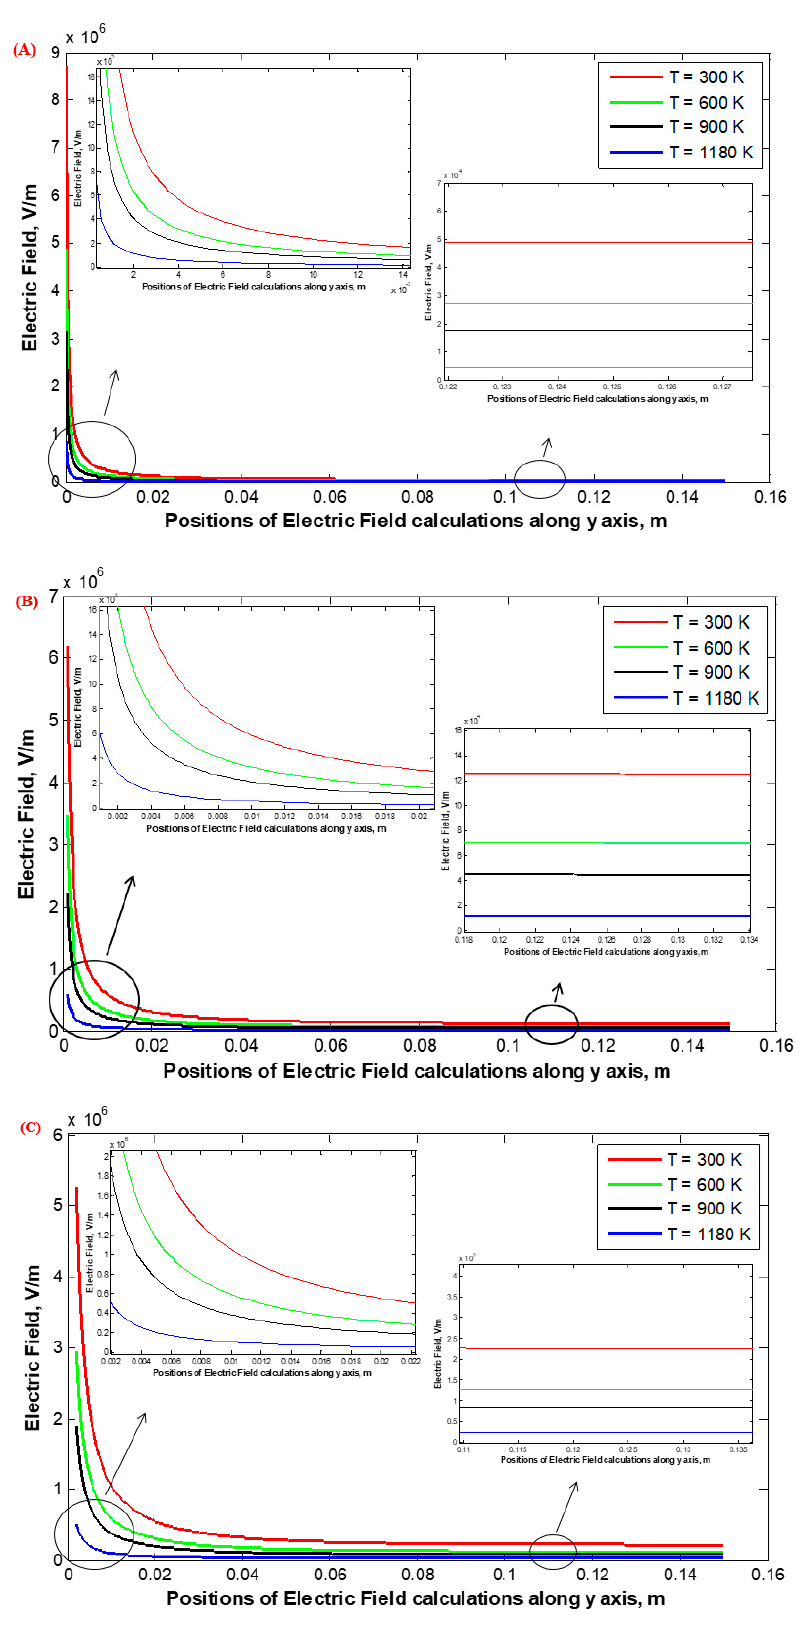
Figure 20. Electrostatic field along the Y -axis of the multi-discharge wire WDESP (five-wire) at a high temperature: ( A ) r c = 0. 26, ( B ) r c = 0. 935, and ( C ) r c = 1.975 mm.